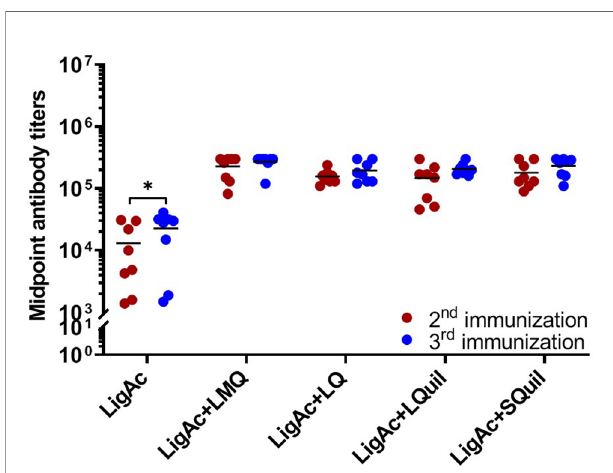
FIGURE 1 | Comparison of LigAc-speci fi c IgG titers after the second and the third immunizations. The antibody titers in the vaccinated hamsters at 1 week after the second and the third immunization were measured by ELISA. Mann – Whitney U test was used to compare antibody titers between groups; * represents p < 0.05.